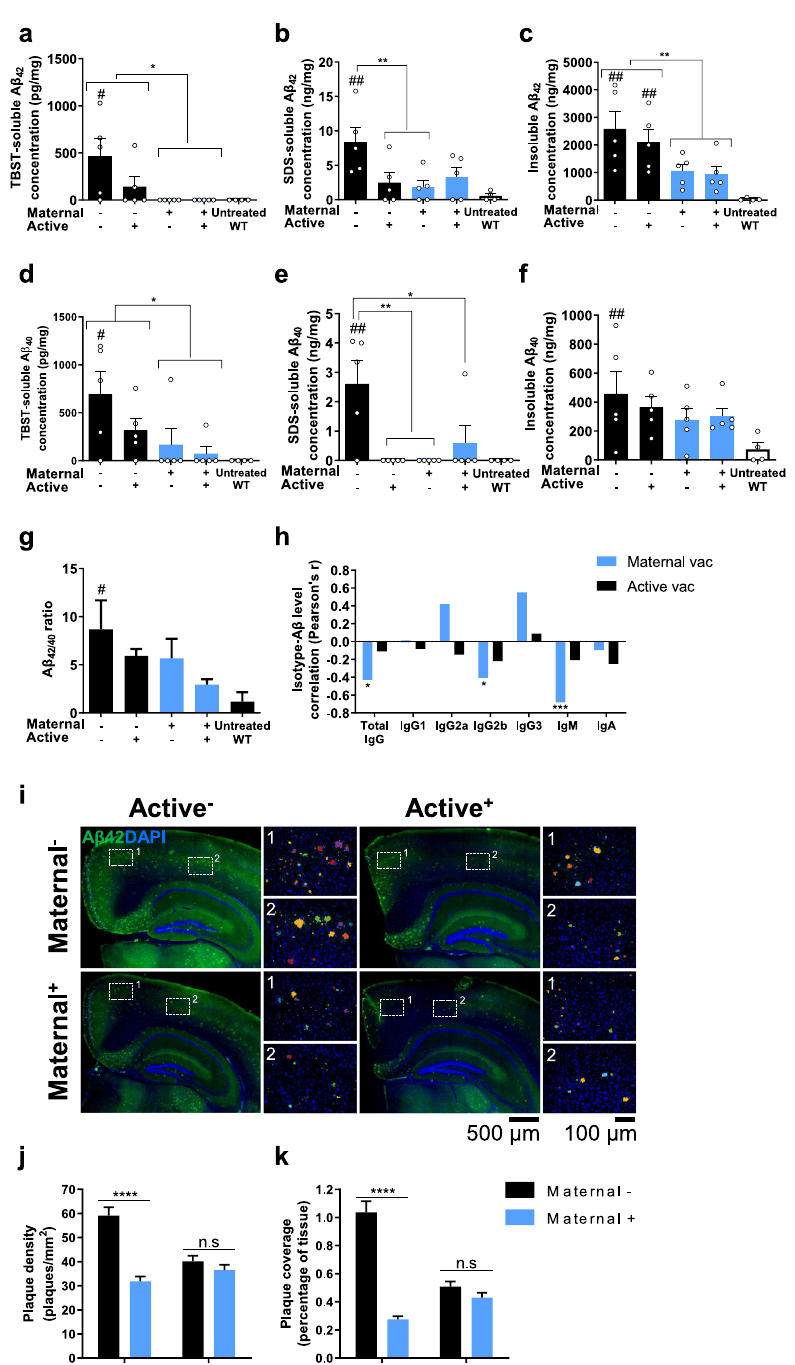
Fig. 4 Maternal vaccination reduces A β pathology independently of anti-A β antibody presence at adulthood. Cortical A β levels were measured using sELISA ( a ) TBST, ( b ) SDS, and ( c ) formic-acid soluble A β 42 ( n = 5 ). ( d ) TBST, ( e ) SDS, and ( f ) formic-acid soluble levels of cortical A β 40 ( n = 5 ). g